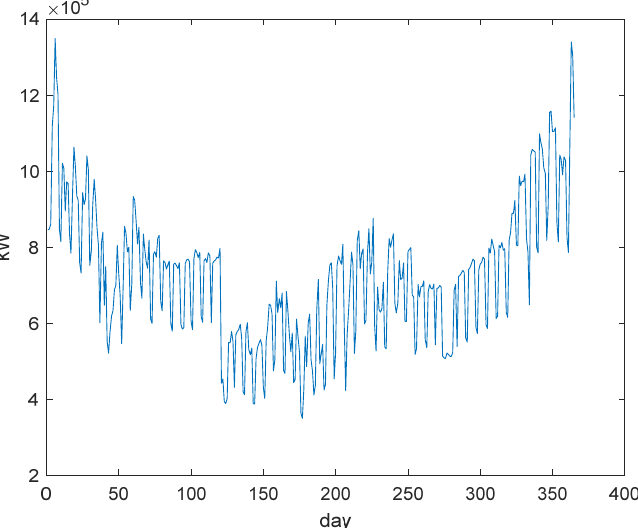
Figure 12. Daily electricity consumption data of charging station operators. The trend component and periodic component are extracted from daily electricity P according to the X12 method.